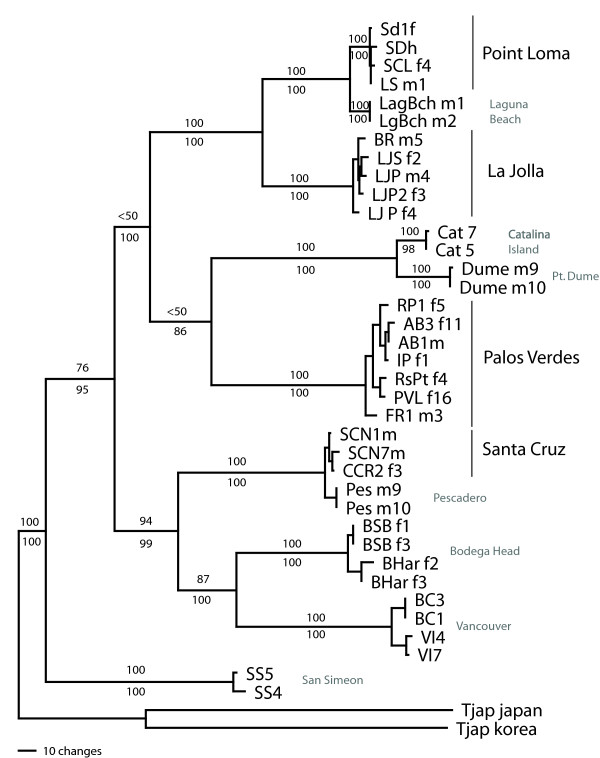
Gene tree for CYTB for selected sites of T. californicus. Tree is one of 16 most parsimonious trees based on the complete nucleotide sequence of CYTB (1131 bp) for taxa representing the range of diversity found within each of the regional areas and the additional site sequences. Bootstrap numbers based upon 10 000 replicates are given above branches (only those supporting regional clades and branches showing the relationships of additional sites are shown). T. japonicus nucleotide CYTB sequences from both Korea and Japan are used to root tree (from GenBank accession numbers AY959338 and AB060648 respectively). The relationships between the regions and additional sites are the same as those obtained in a Bayesian phylogenetic analysis. Credibility values from this analysis are given below each branch.